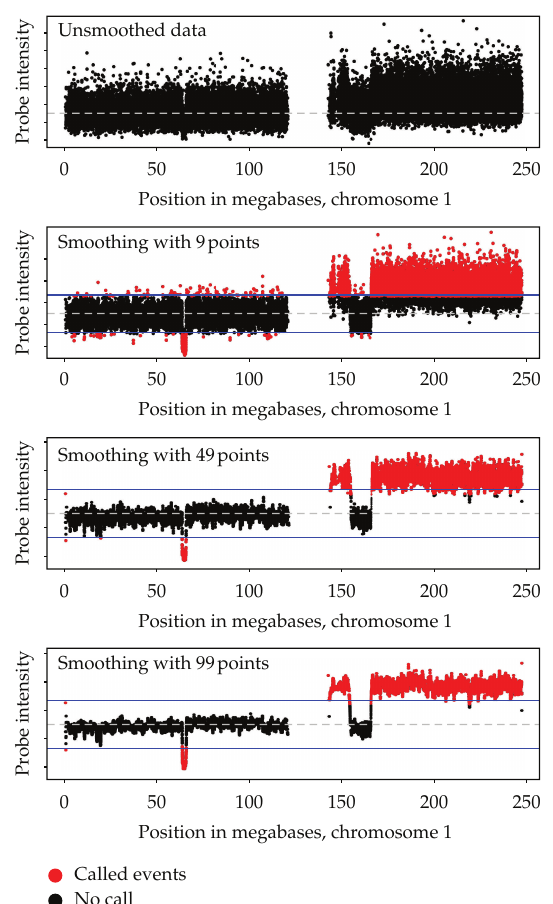
Figure 3: A representative primary tumor chromosome 1 copy number profile (cid:2) top panel (cid:3) and corresponding S (cid:2) CN (cid:3) n (cid:4) k (cid:8) { 9 , 49 , 99 } (cid:5) in the bottom panels. Therefore, n (cid:8) 3 because three di ff erent smoothing lengths are used. Black probes represent probes that are not called while red probes are the called events that exceed the amplification and deletion